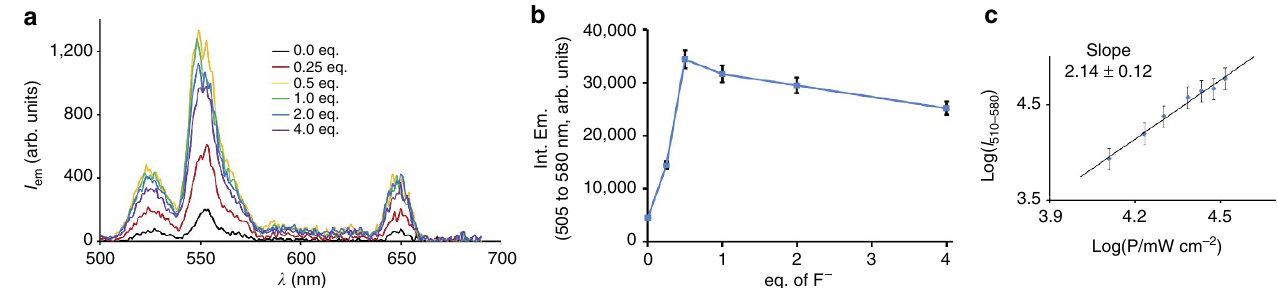
Figure 3 | UC emission spectroscopy. Excitation of a 1mM solution of the Er complex in D 2 O into the Er 4 I 15/2 - 4 I 11/2 absorption band at 980nm revealed ( a ) a weak UC emission signal in the visible region associated to Er emission (black curve). Upon titration by fluoride anions, the UC emission strongly increased up to 0.5 equivalent (eq.) of fluoride (orange), as revealed ( b ) by the evolution of the intensity increase (integrated from 505 to 580nm) as a function of added fluoride anions. ( c ) Plotting the UC emitted intensity (integrated from 505 to 580nm) as a function of the incident pump intensity at 980nm in a Log-Log format for the solution containing 0.5 eq. of fluoride anions gave a slope which corresponds to a two photon process (Errors were estimated assuming a Poisson’s law for the